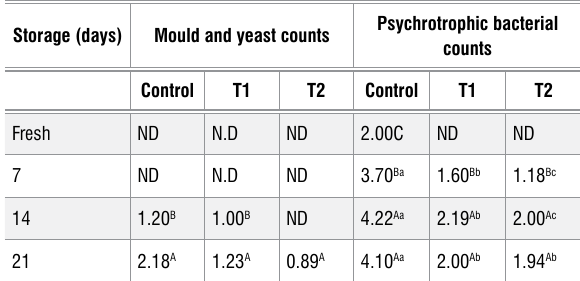
Counts of mould, yeast and psychrotrophic bacteria counts in stirred yoghurt treatments during the storage period